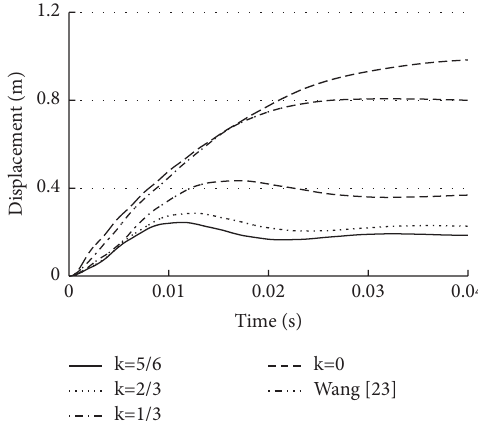
Figure 8: Vertical displacements-time curves at the central node of the free end.